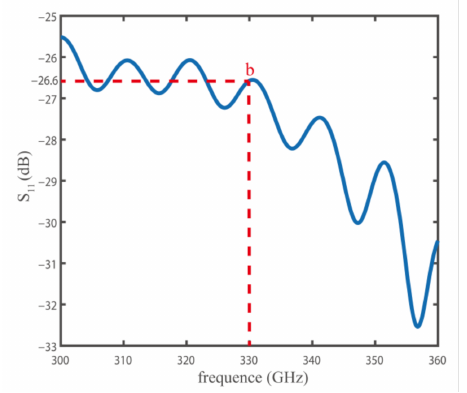
Figure 3. Simulation results of S 11 parameter (the reflection of TE 11 mode) ranging from 300 to 360 GHz. Point b is the S 11 parameter whose value is − 26.6 dB at the frequency of 330 GHz.